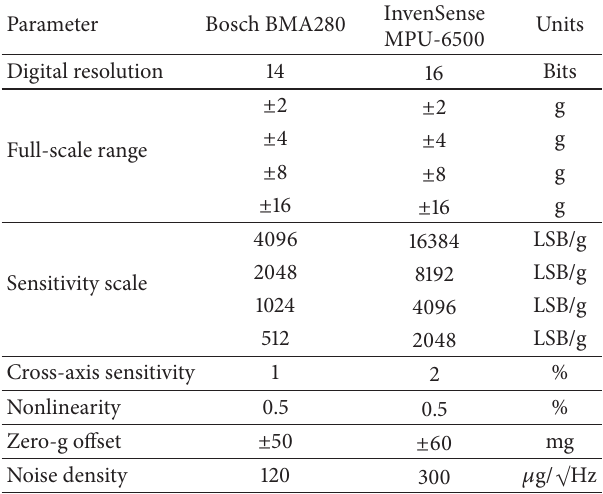
Table 4: Bosch BMA280 and InvenSense MPU-6500 accelerometer properties.